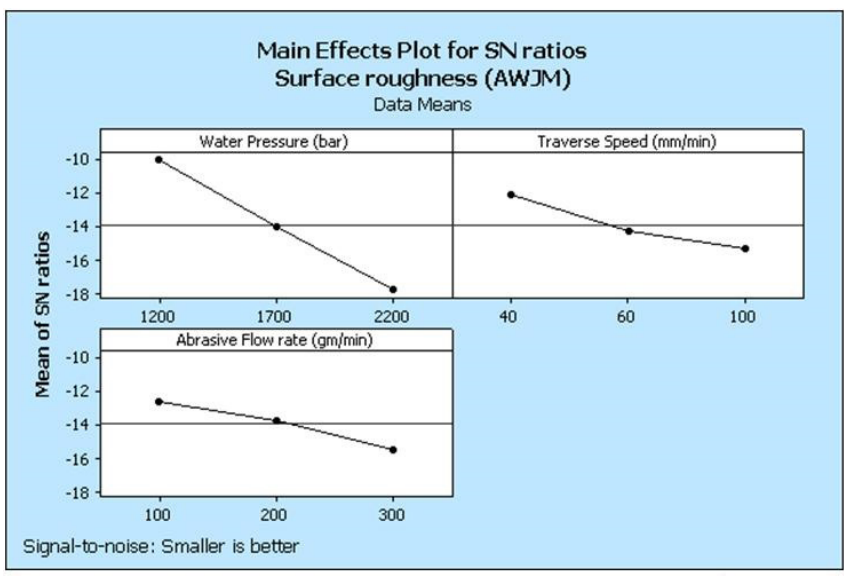
Figure 9. Main effects plot for SN ratios - SR-AWJM.